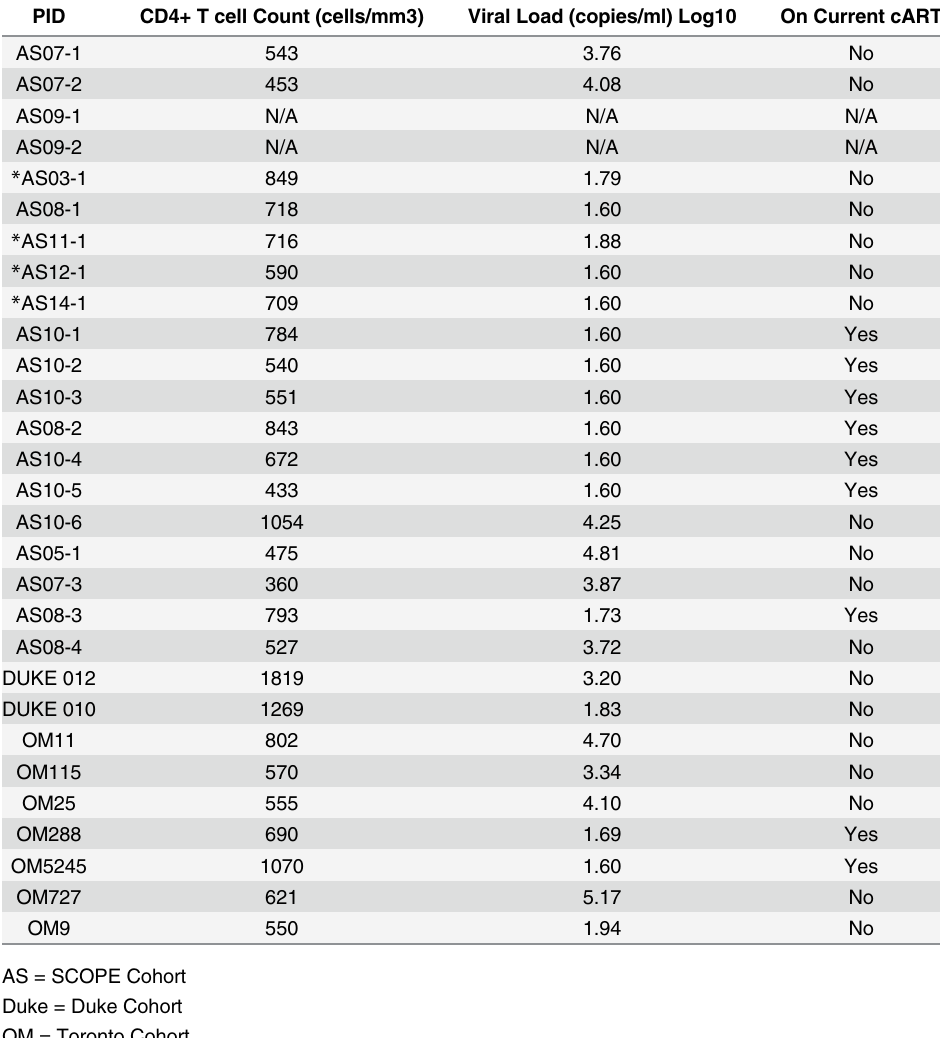
Table 2. Description of participants for in vitro mAb